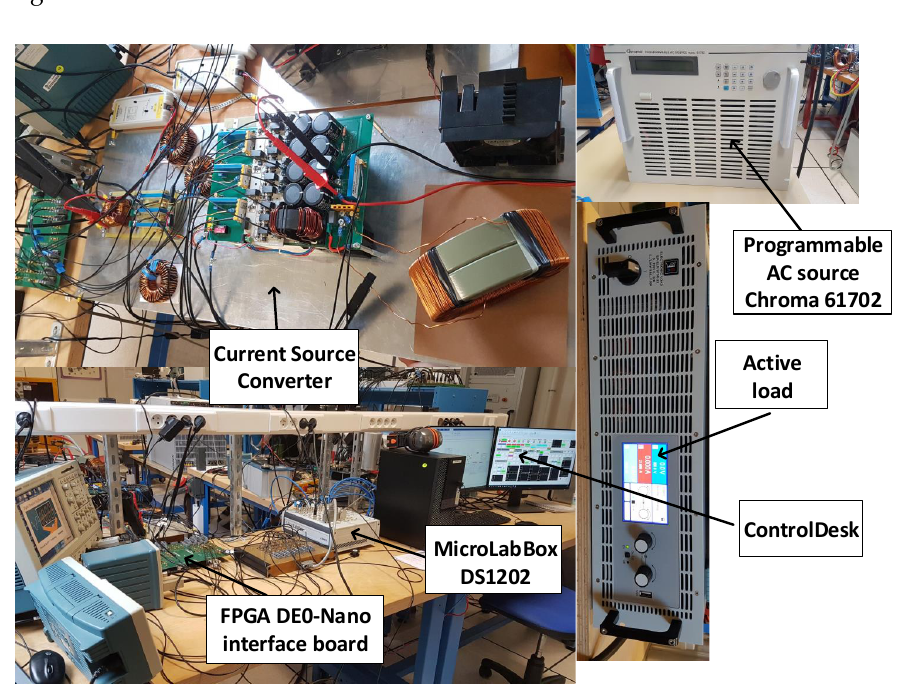
Figure 16. Experimental